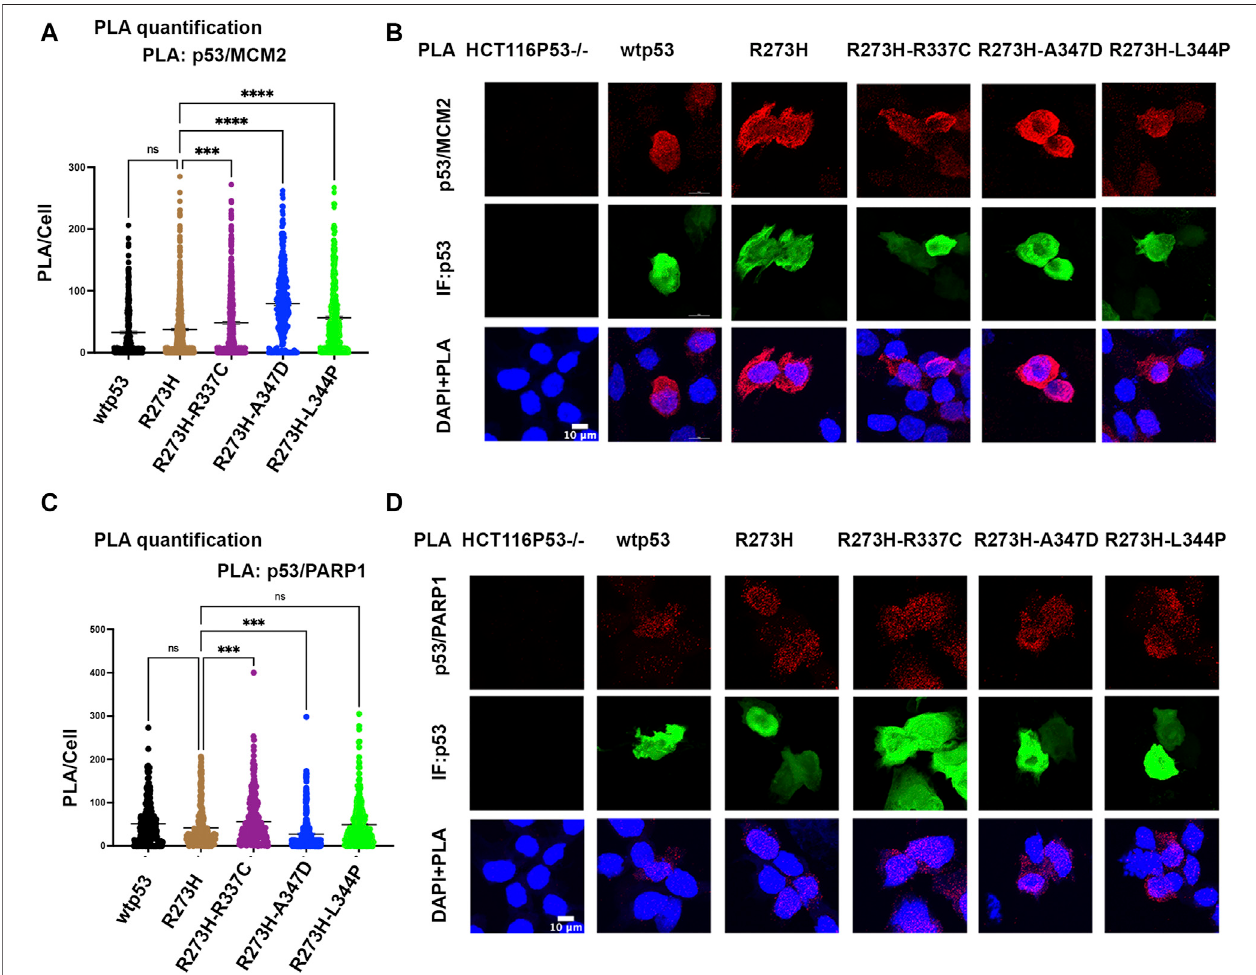
FIGURE4| Destabilizing oligomerization ofR273H mtp53 doesnot block theinteraction betweenmtp53 and MCM2. HCT116 p53 − / − cells weretransfected with wtp53, mtp53 R273H, or dual mutants R273H-R337C, R273H-A347D, R273H-L344P expressing plasmids. (A) Analysis of p53/MCM2 complexes by in situ proximity ligation assay (PLA). Fluorescent foci per cell were counted using Cellpro fi ler software and depicted as a scatter plot using GraphPad Prism 9. The data represent a scatter plot with n (cid:2) 3. An ordinary one-way ANOVA was used to determine the statistical signi fi cance of the data. The following format was used to assign signi fi cance based on p -value: **** represents a p -value ≤ 0.0001 and ns represent non-signi fi cant. (B) Representative confocal microscope images of p53/MCM2 complexes (red) by in situ proximity ligation assay (PLA), p53 expression (green) by immuno fl uorescence microscopy. DNA was counterstained with DAPI (blue). The z-stack maximum intensity projection images are shown. Three independent experiments were performed. (Scale bar (cid:2) 10 µm). (C) Analysis of p53/PARP1 complexes by in situ proximity ligation assay (PLA). Fluorescent foci per cell were counted using Cellpro fi ler software and depicted as a scatter plot using GraphPad Prism 9. The data represent a scatter plot with n (cid:2) 3. An ordinary one-way ANOVA was used to determine the statistical signi fi cance of the data. The following format was used to assign signi fi cance based on p -value: **** represents a p -value ≤ 0.0001 and ns represent non-signi fi cant. (D) Representative confocal microscope images of p53/ PARP1 foci/complexes (red) by in situ proximity ligation assay (PLA), p53 expression (green) by immuno fl uorescence microscopy. DNA was counterstained with DAPI (blue). The z-stack maximum intensity projection images are shown. Three independent experiments were performed. (Scale bar (cid:2) 10 µm).